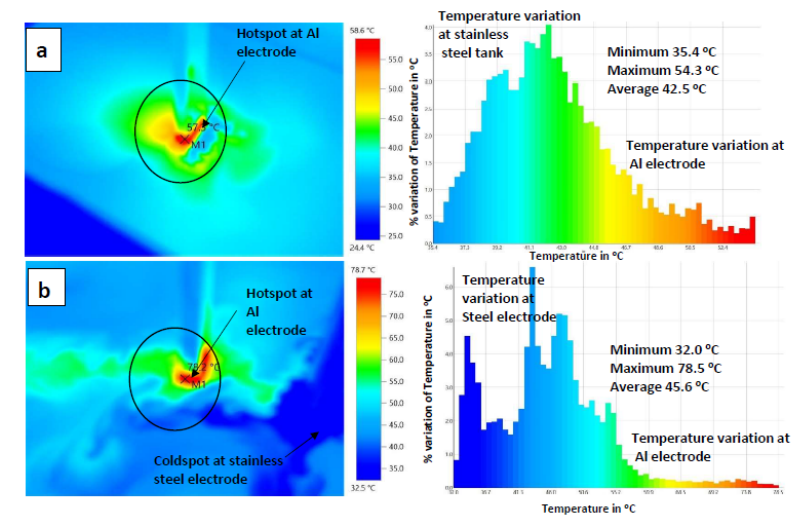
Figure 7: Temperature variation at the a) steel tank and electrode b) at two electrodes.